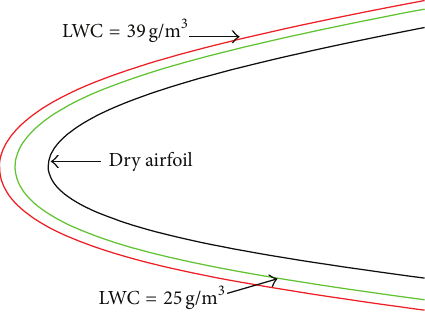
Figure 20: Water film thickness comparison between different LWC conditions at AOA = 14 degree.